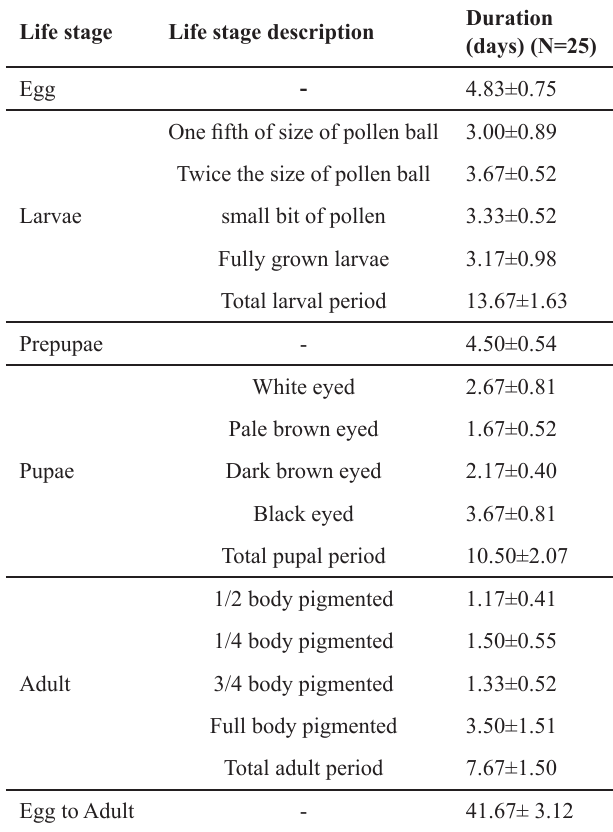
Table 1. Life cycle of Ceratina binghami .